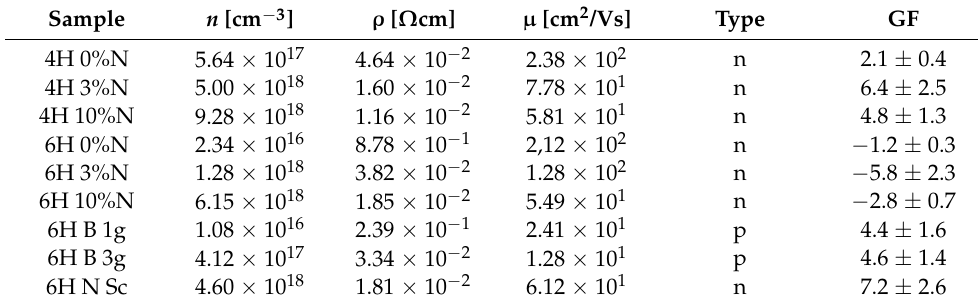
Figure 10. X-ray diffraction pattern for 4H- ( a ) and 6H- ( b ) SiC, and the X-ray rocking curve for 4H-SiC ( c ). Table 2. The results of Hall and GF measurements for the bulk SiC crystals with various